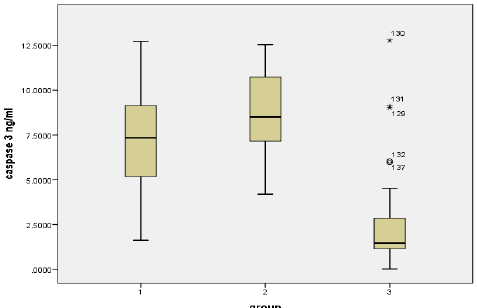
Figure 2. Caspase 3 levels (ng/mL) in the study groups. Group 1: Tobacco chewers with OSCC, Group 2: Habitual tobacco chewers without any precancerous or cancerous lesion in the oral cavity, Group 3: Controls.